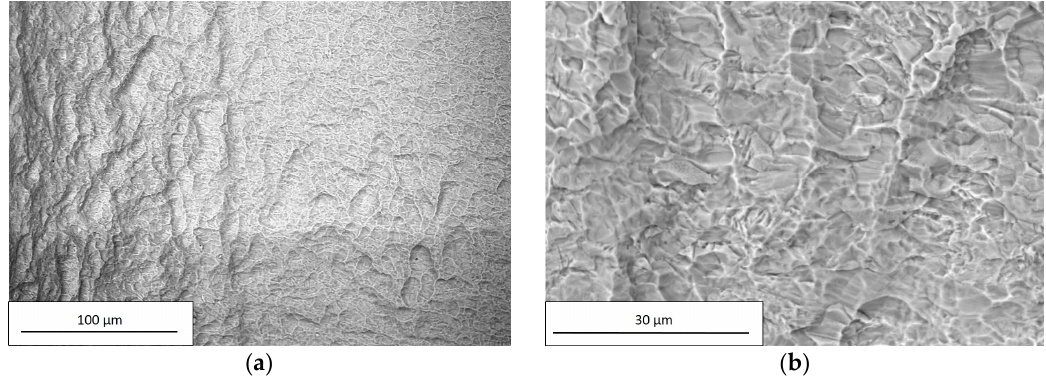
Figure 11. SEM observation of D, acquired using a Hitachi TM3000 with a magnification of ( a ) 250× and ( b ) 2500×.